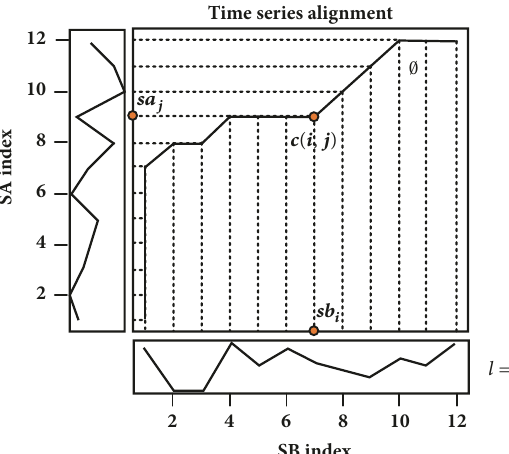
Figure 1: Framework of proposed method.